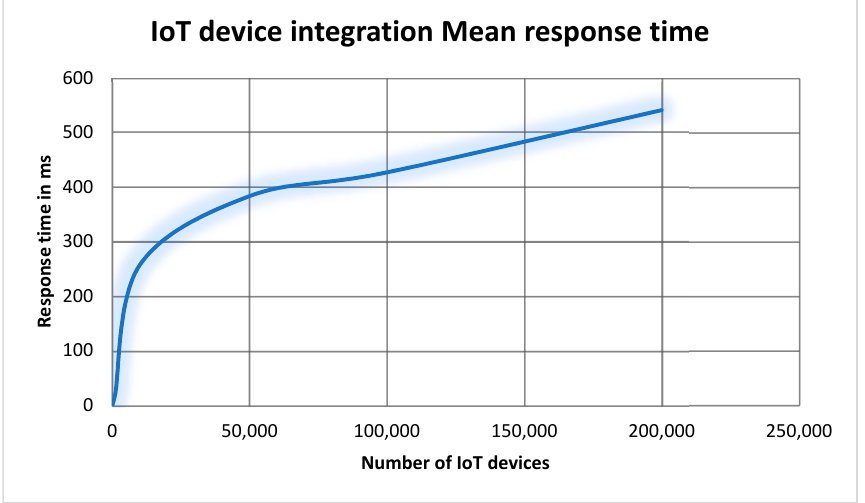
Figure 12. The relationship between the number of integrated IoT devices and the mean response time.